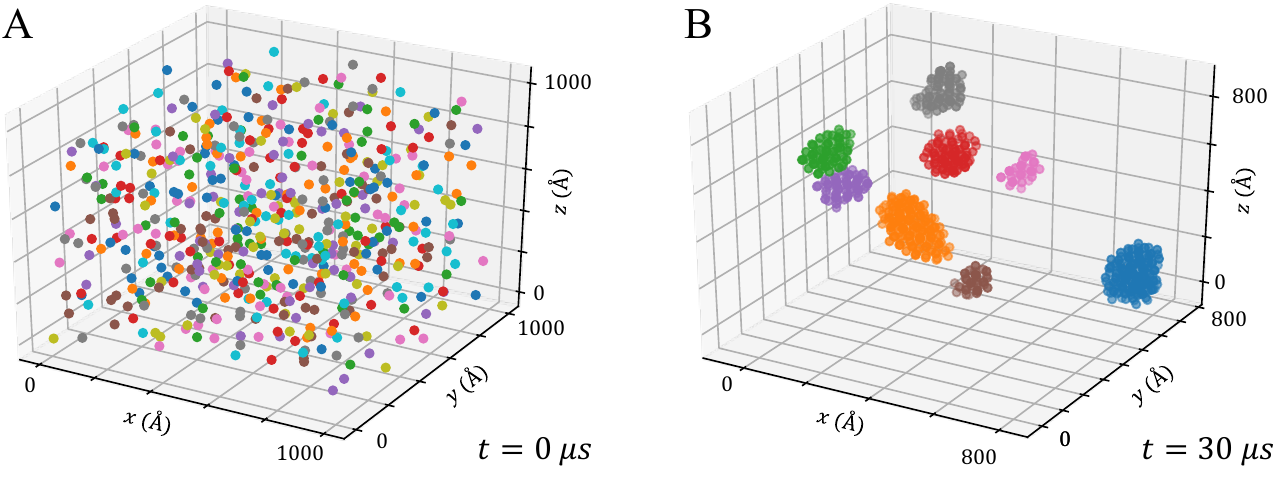
Figure 3. Formation of clusters during a BD production run of 600 NPs of Ti reported as an example; ( A ) Initial configuration with randomly distributed and isolated NPs; ( B ) After 3 µ s, the particles formed 8 major aggregates. For a detailed view on xy , xz and yz planes, see Figure